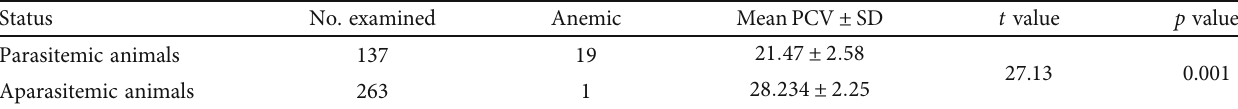
Table 3: Mean PCV of trypanosome-infected and uninfected cattle in the study